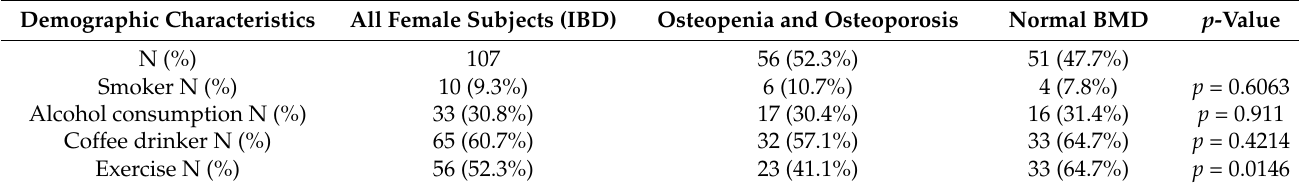
Table 8. The lifestyle parameters of the study IBD female patients with respect to osteoporosis and osteopenia. Demographic Characteristics